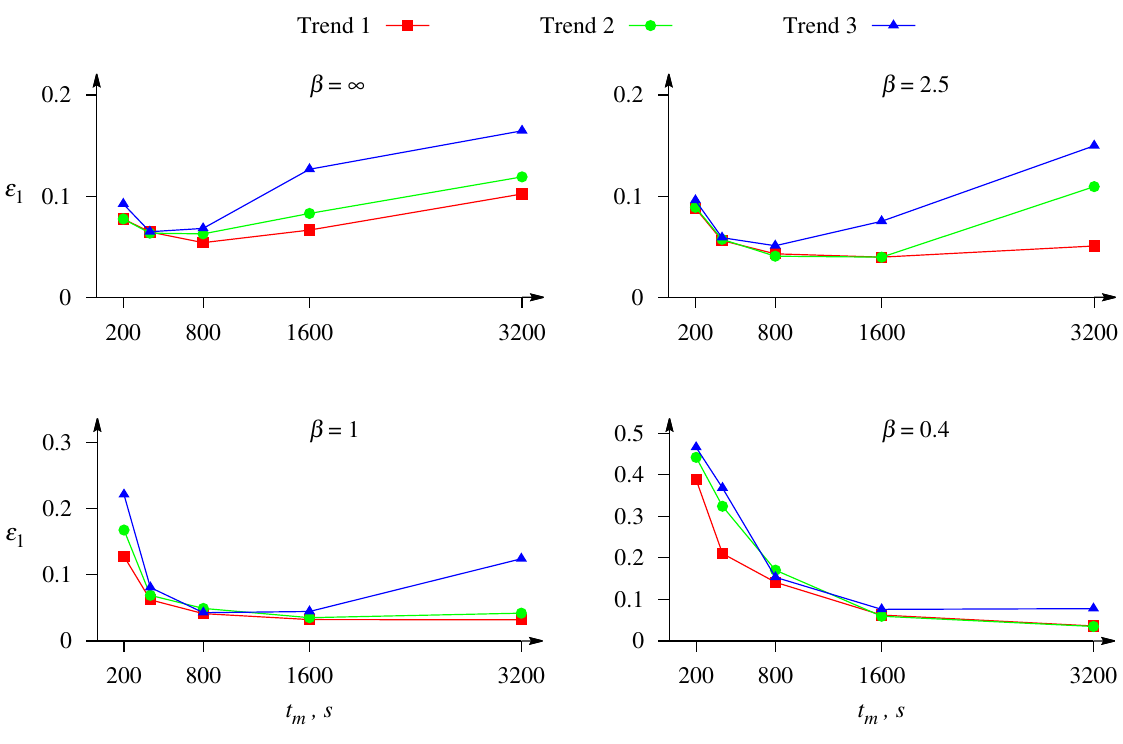
Figure 6. The relative error, ε , of the evaluation of the concentration, c 1 t , of the biosensor operation at different values of the Biot number, β , when the response is m affected by white Gaussian noise with σ = 0 . 05 and the exponential trend of a different rate. The other parameters are as in Figure